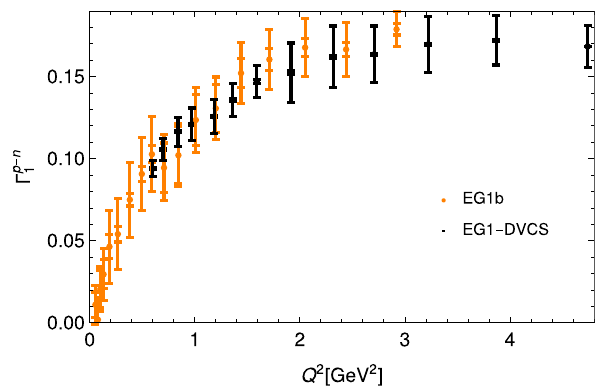
− n ( Q 2 ; inel ) for two of the consid- j 1 − n ( Q 2 ; inel ) = σ j , stat ; the stat j 1 − n ( Q 2 ; inel ) = σ j , sys We note that the sys j 1